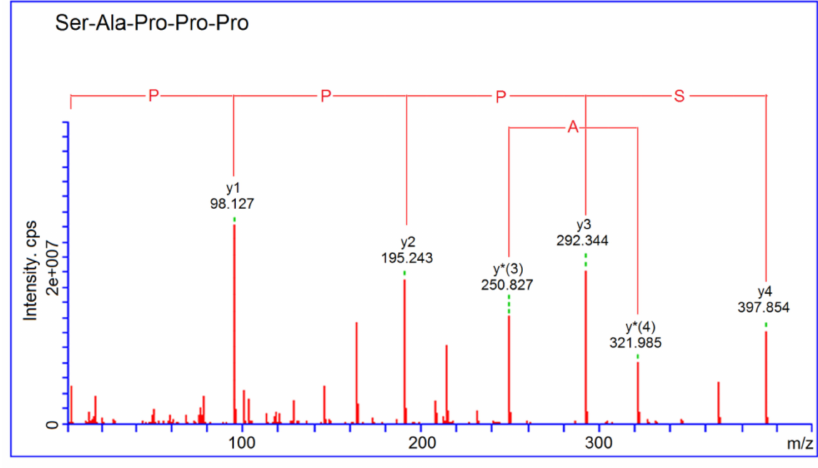
Figure 3. ESI-MS/MS spectra of SAPPP identified in quinoa globulin hydrolysates.